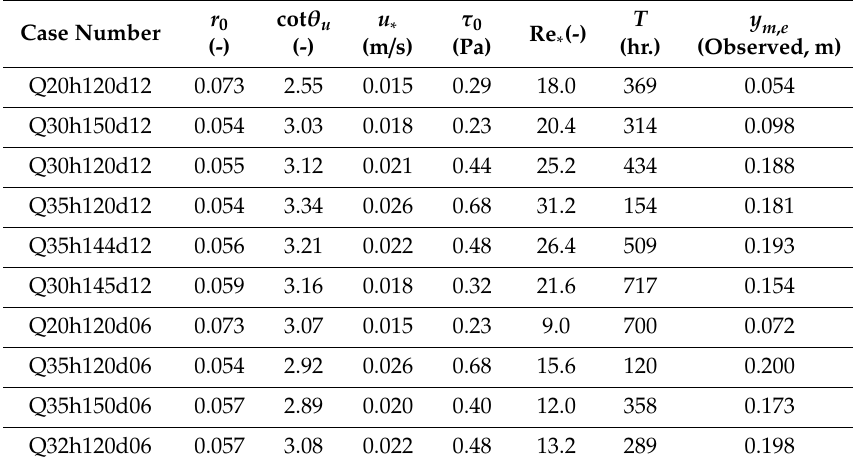
Figure 6. Vertical distributions of flow and turbulence at the longitudinal transition. u and u ∗ denote point velocity and bed shear velocities, respectively. And k is turbulent kinetic energy per unit mass. Table 2. Results of scour